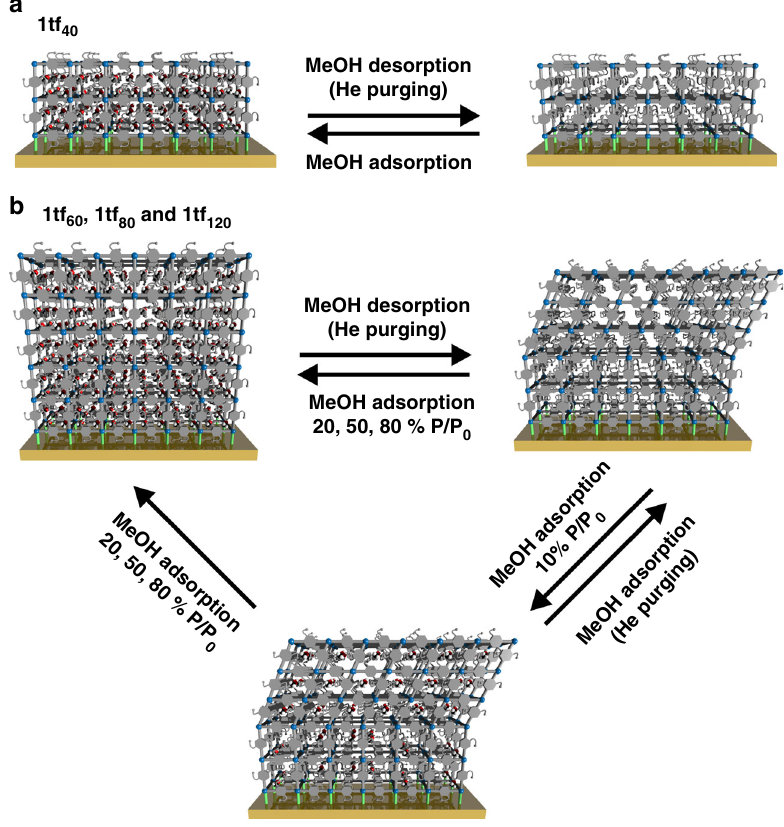
Fig. 5 Schematic representation of the structural response of 1tf x upon methanol sorption. 1tf x materials exhibit a unique structural transition depending on the total number of LPE fabrication cycles (i.e., the crystallite dimension and/or fi lm thickness). a 1tf 40 remains in the lp form, regardless of the treatments, indicating the restriction of the framework transition when anchored on the surface. b The fi lms with larger crystallite-dimension ( 1tf 60 , 1tf 80 and 1tf 120 ) surprisingly reveal a unique structural fl exibility. The crystallites domains close to the interface with the substrate surface remain in the lp form, while the domains in suf fi cient distance to the surface can undergo a lp -to- np breathing transition upon activation. Hence, both the lp and np forms are presented at the activated stage. Adsorption of methanol vapour of at least 20% P / P 0 is required for the reverse np -to- lp structural transition to the solvated, lp stage. Unlike the case of 1bulk , 10% P / P 0 of methanol vapour can be adsorbed in 1tf x but cannot induce the structural